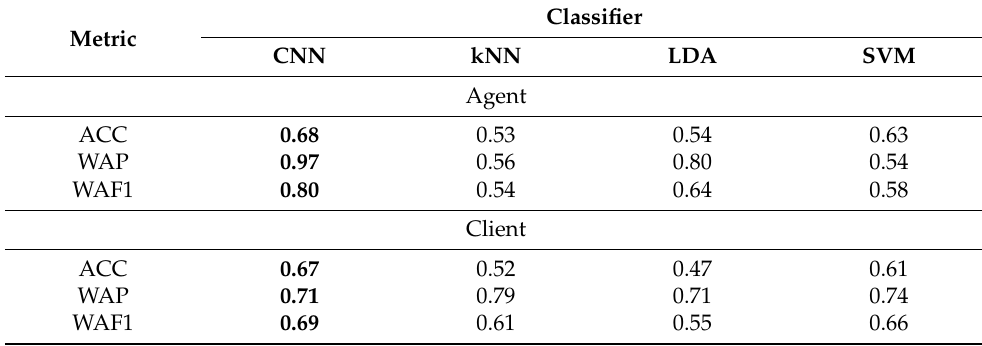
Table 12. Verification of the method based on the DBV2 database.